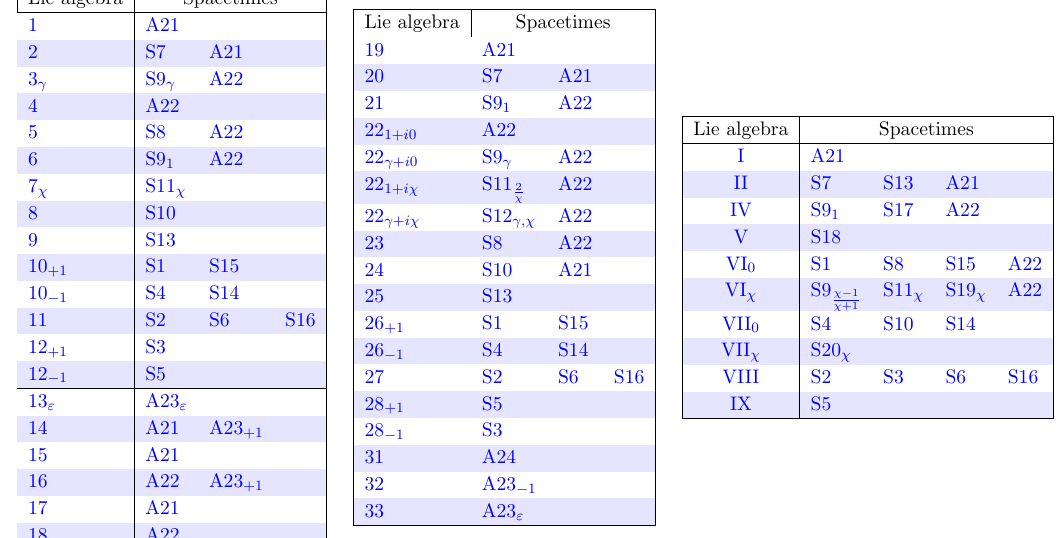
Table 15 . Kinematical Lie algebras and their homogeneous